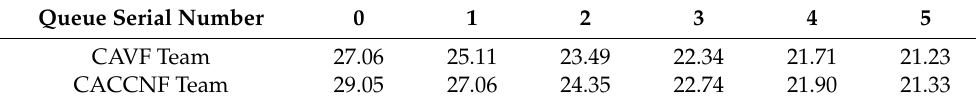
Table 4. Comparison of the 20 s follow-up distance between CAVF fleet and CACCNF fleet. Queue Serial Number